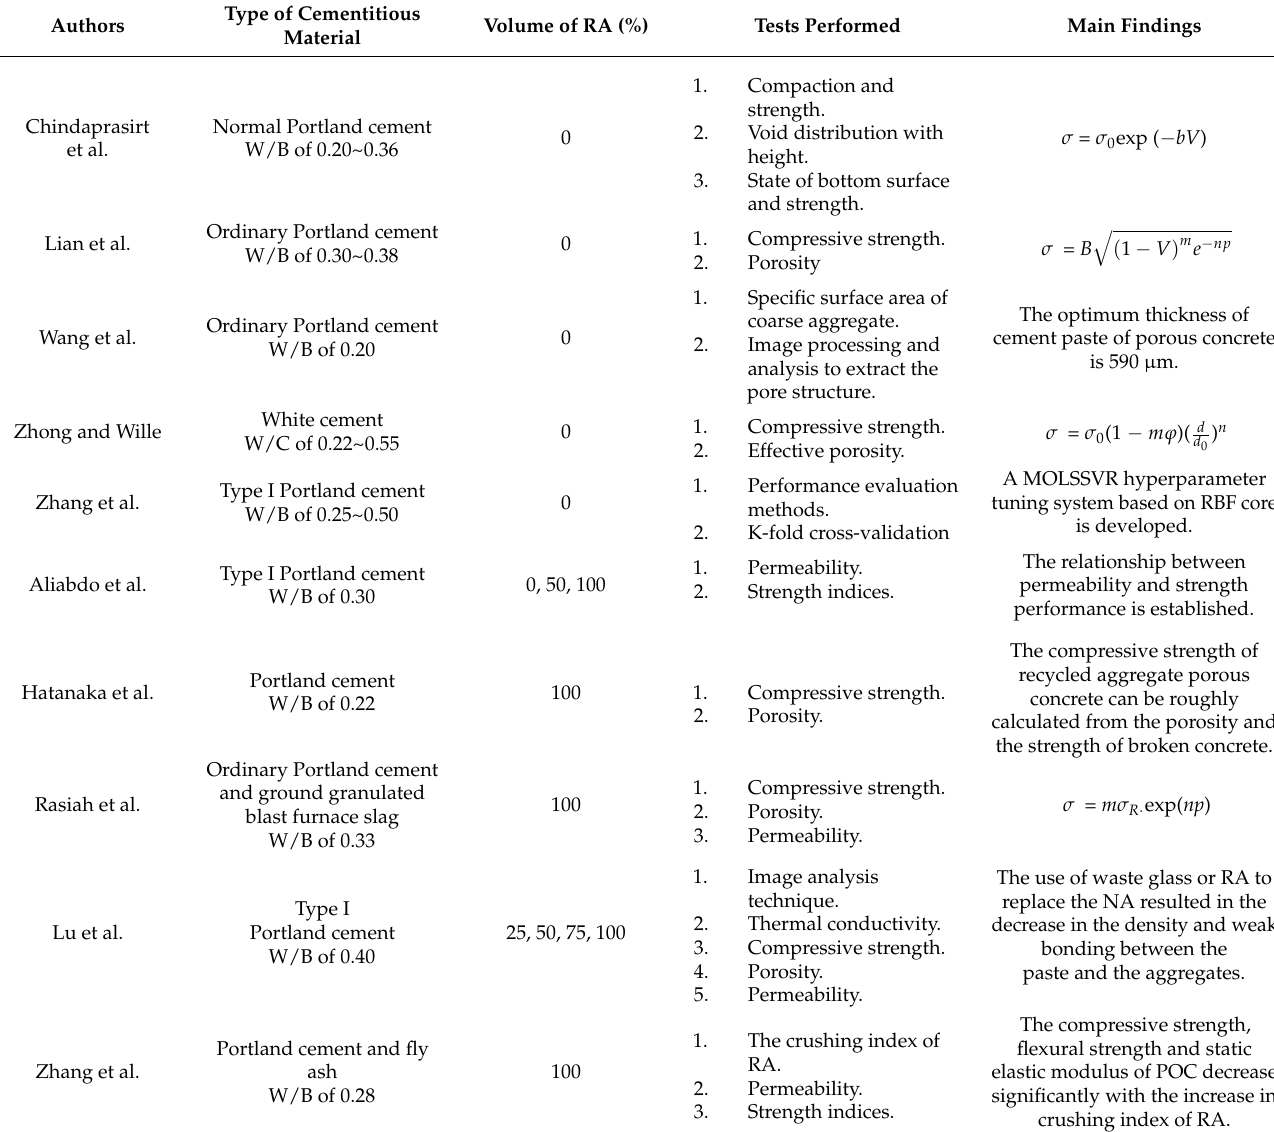
Table 1. Summary of previous